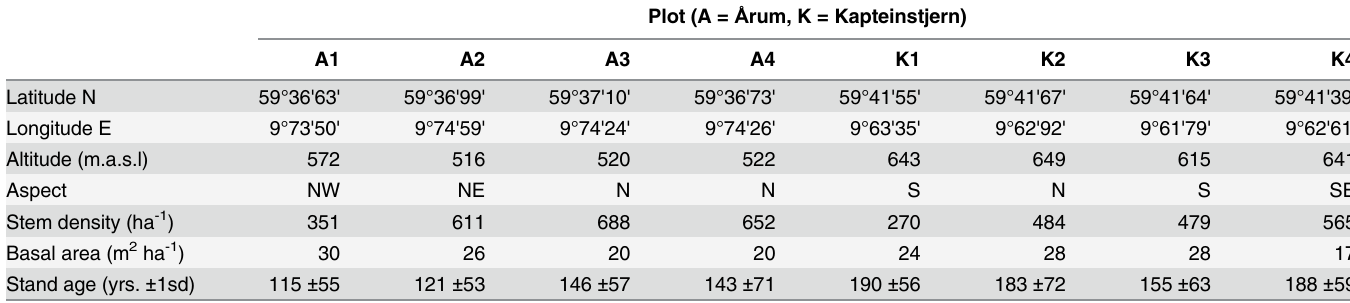
Table 1. Background information of the study plots.